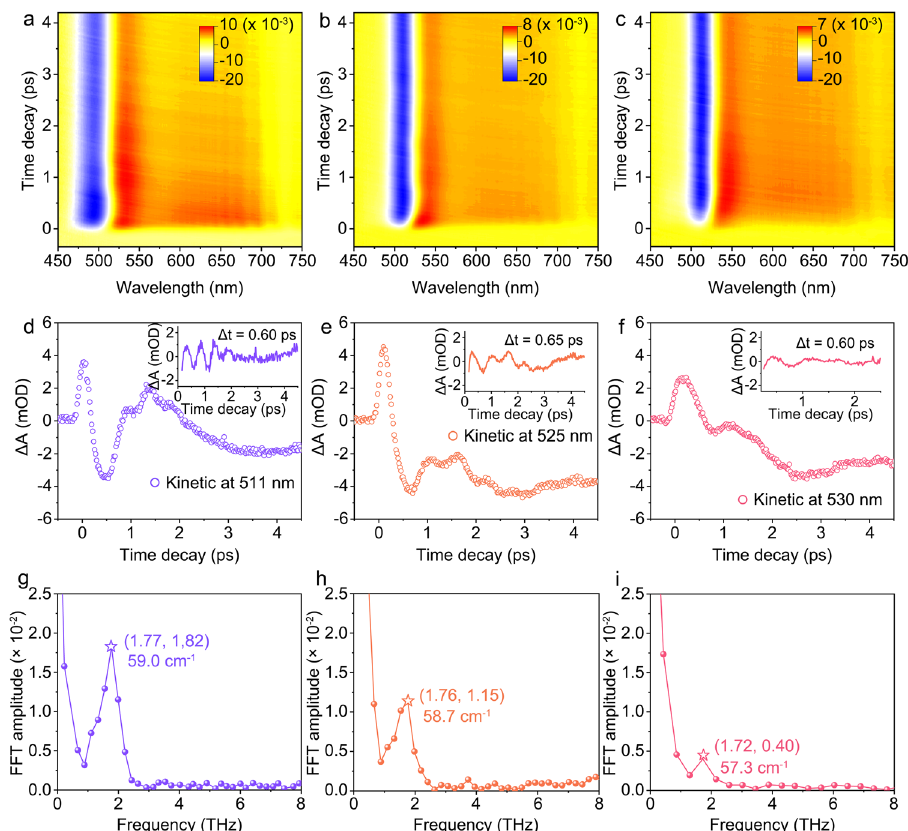
Fig.4|ThedetectionofcoherentoscillationsofmetalkernelinAu-1,Au-2,and Au-3NCs. a – c Short-range femtosecond-TAdata maps of Au-1, Au-2, andAu-3 NCs between 0.3ps and 4.5ps upon the excitation of 400nm. The scaling of the color scalesistheabsorptionintensity,andtheunitsaremilli-opticaldensity. d – f Kinetic tracesatzeropositionsat511,525,and530nmintheTAmapsofAu-1,Au-2,andAu- 3NCs;thezeropositionsarethecrosslinesthattheelectrondynamicisinhibitedto